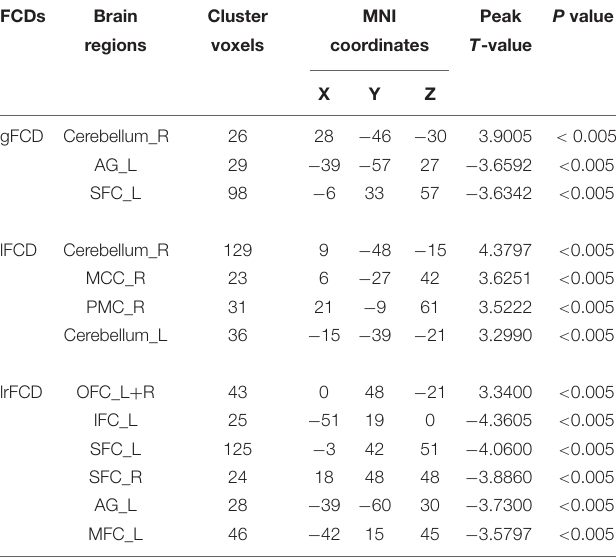
TABLE 2 | Discriminative gFCD, lFCD and lrFCD between HCs and individuals with